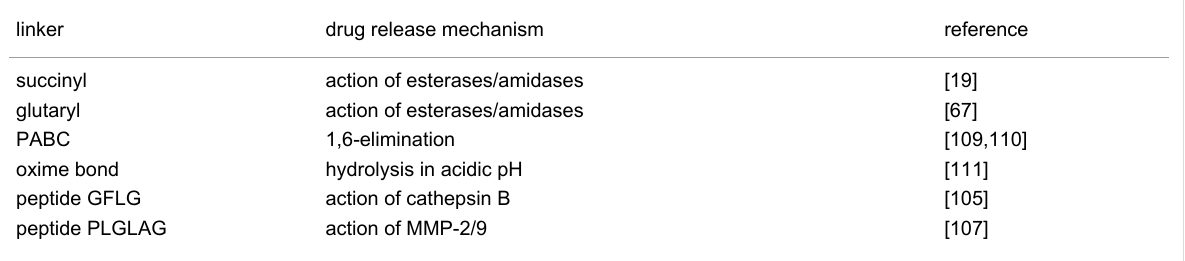
Table 2: Representative examples of biodegradable/responsive linkers utilized for the formulation of PDCs in cancer.